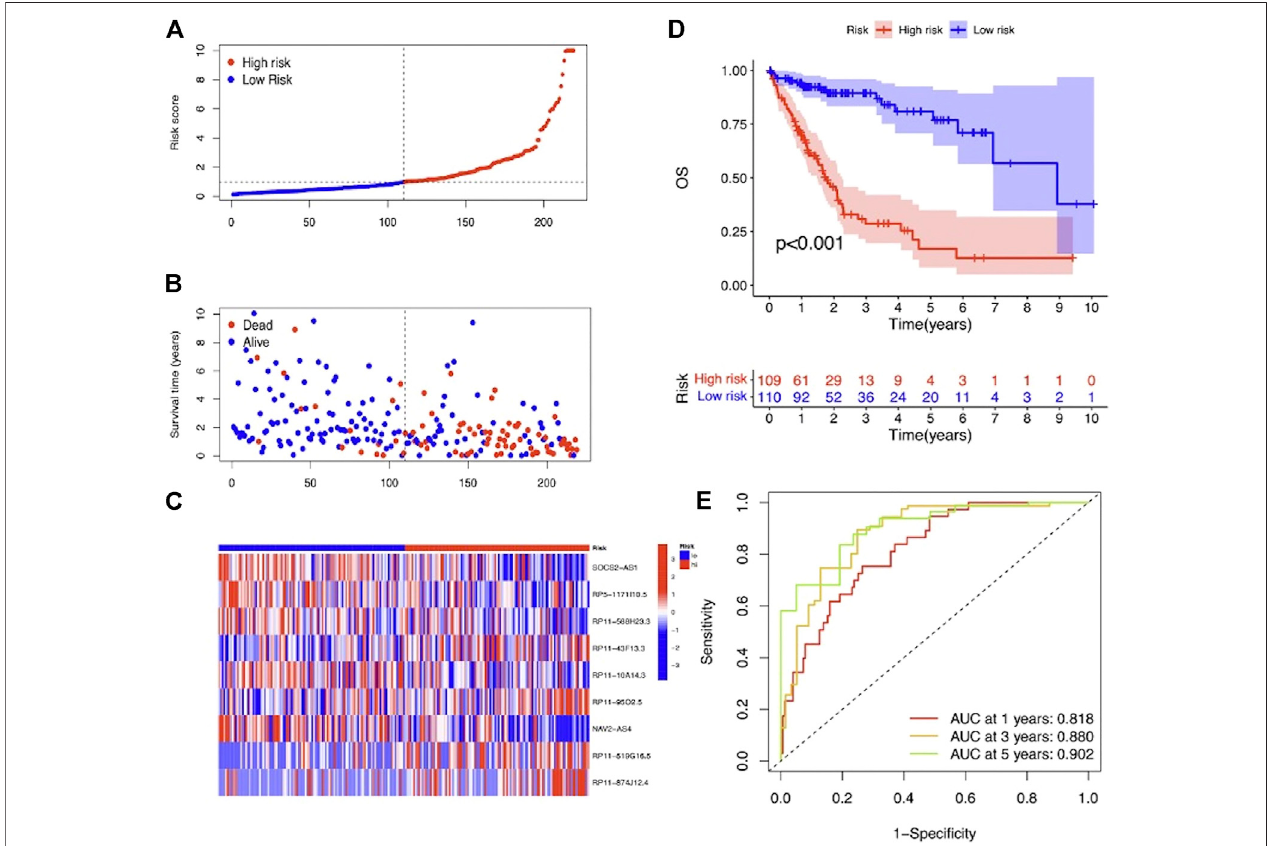
FIGURE 4 | Prognostic value of the 9-m7G-related-lncRNA risk model between the two groups in the training set. (A) Distribution of the risk score (the x-axis representedtheLIHCpatientsarrangedaccordingtotheriskscore,andthey-axisrepresentedvaluesoftheriskscoreforeachpatient). (B) Scatterplotofsurvivalstatus and riskscore(the x-axis represented the LIHC patients arranged according tothe risk score, and the y-axis represented thesurvivaltimeofeach patient). (C) Heatmap oftheexpressionpro fi leofthe9m7G-relatedlncRNAs. (D) KMcurvesdisplayedtheOSofLIHCpatientsbetweenhigh-andlow-riskgroups. (E) ROCcurvesofthe risk model of 1, 3, and 5 years for